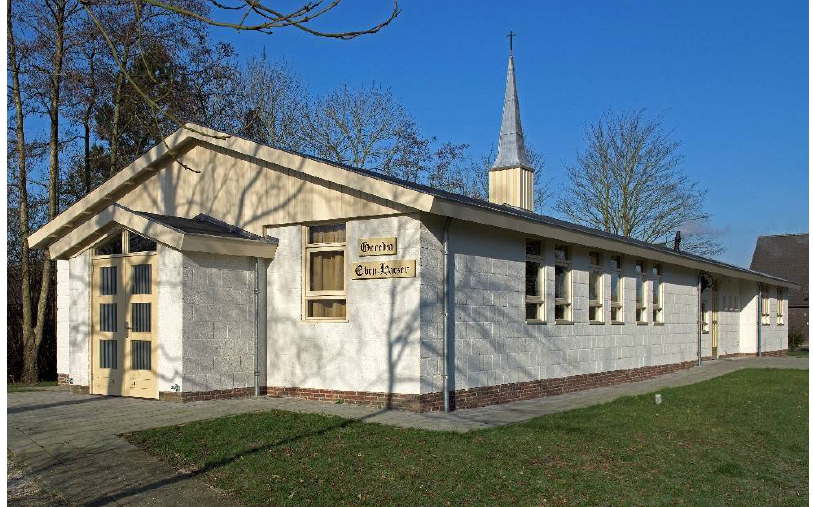
Figure 11. Appingedam (Frisia), the “semi-permanent” Moluccans’ church from 1960 is a reminder of their struggle for an independent state (photo: Jim Ernst).